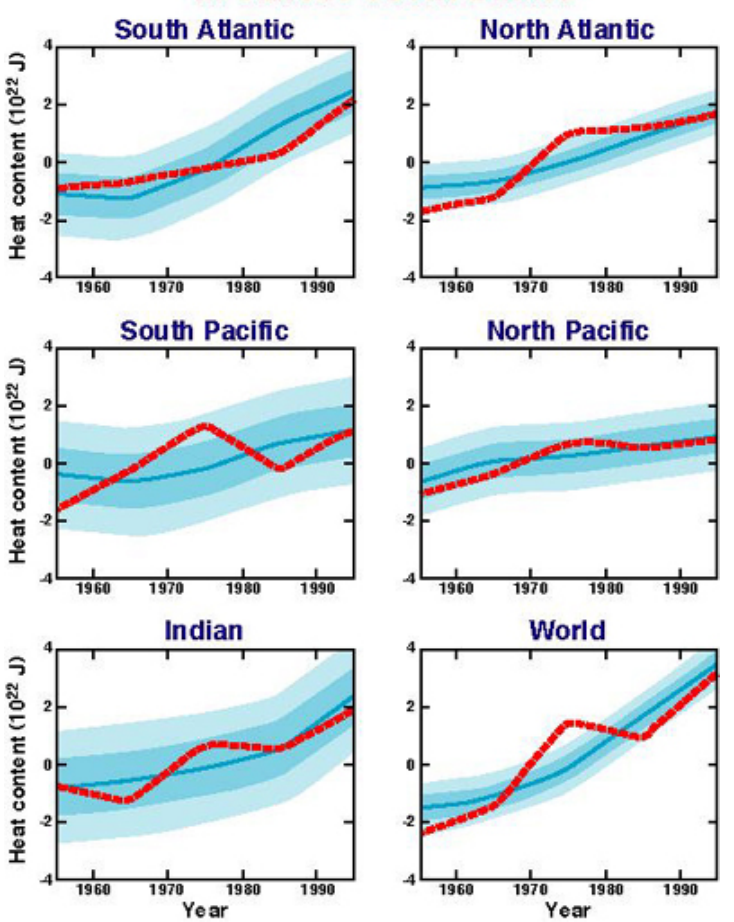
FIGURE 21. Comparisons of observations and modeled ocean heat content/temperatures. (a) Decadal values of anomalous heat content in various ocean basins. The heavy dashed line is from observations and the solid line is the average of five realizations of the PCM forced by observed and estimated anthropogenic sources. The shaded bands denote one and two standard deviations about the model mean. (b) Decadal temperature anomalies (°C) in various ocean basins since 1870 from the PCM. Gray-shaded regions indicate signals statistically distinguishable from